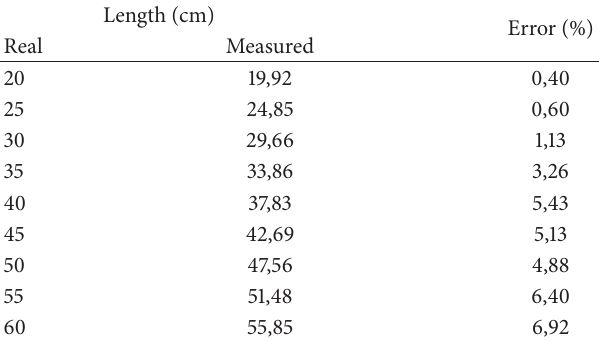
Table 2: Length from the test